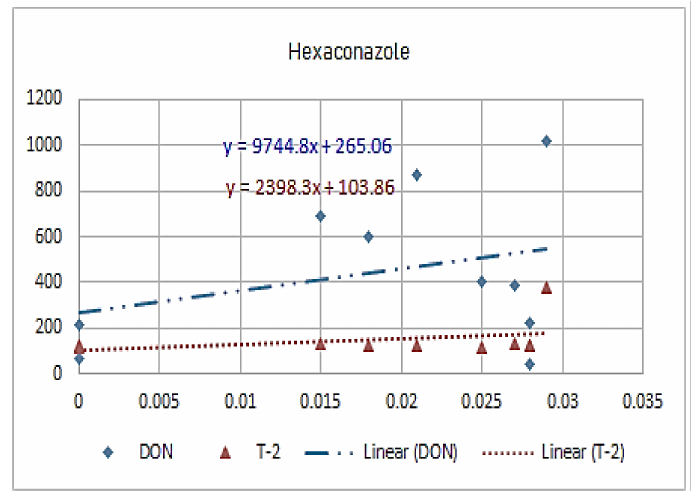
Figure 3. The relation between hexaconazole residue (ppb) and DON and T-2 toxin (ppb) in wheat samples.